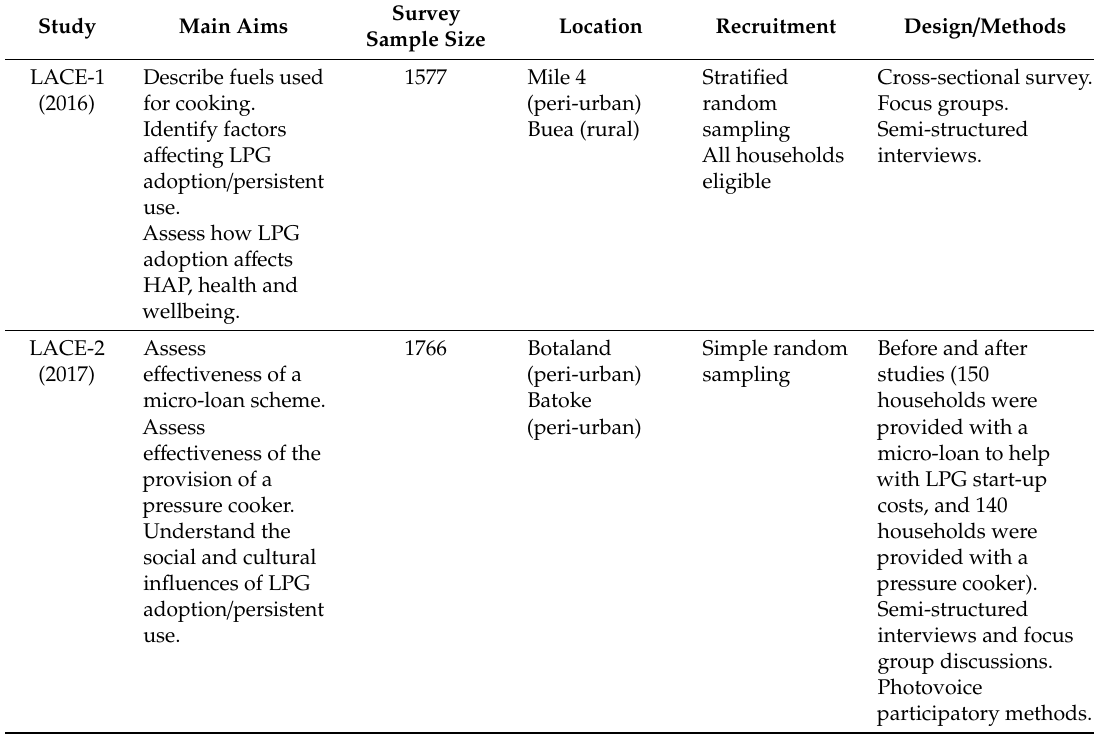
Table 2. Details of the designs, aims and sample sizes of the LACE-1 and LACE-2